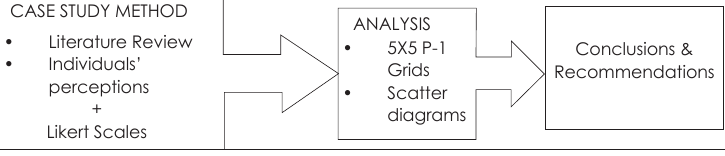
Figure 2: Research